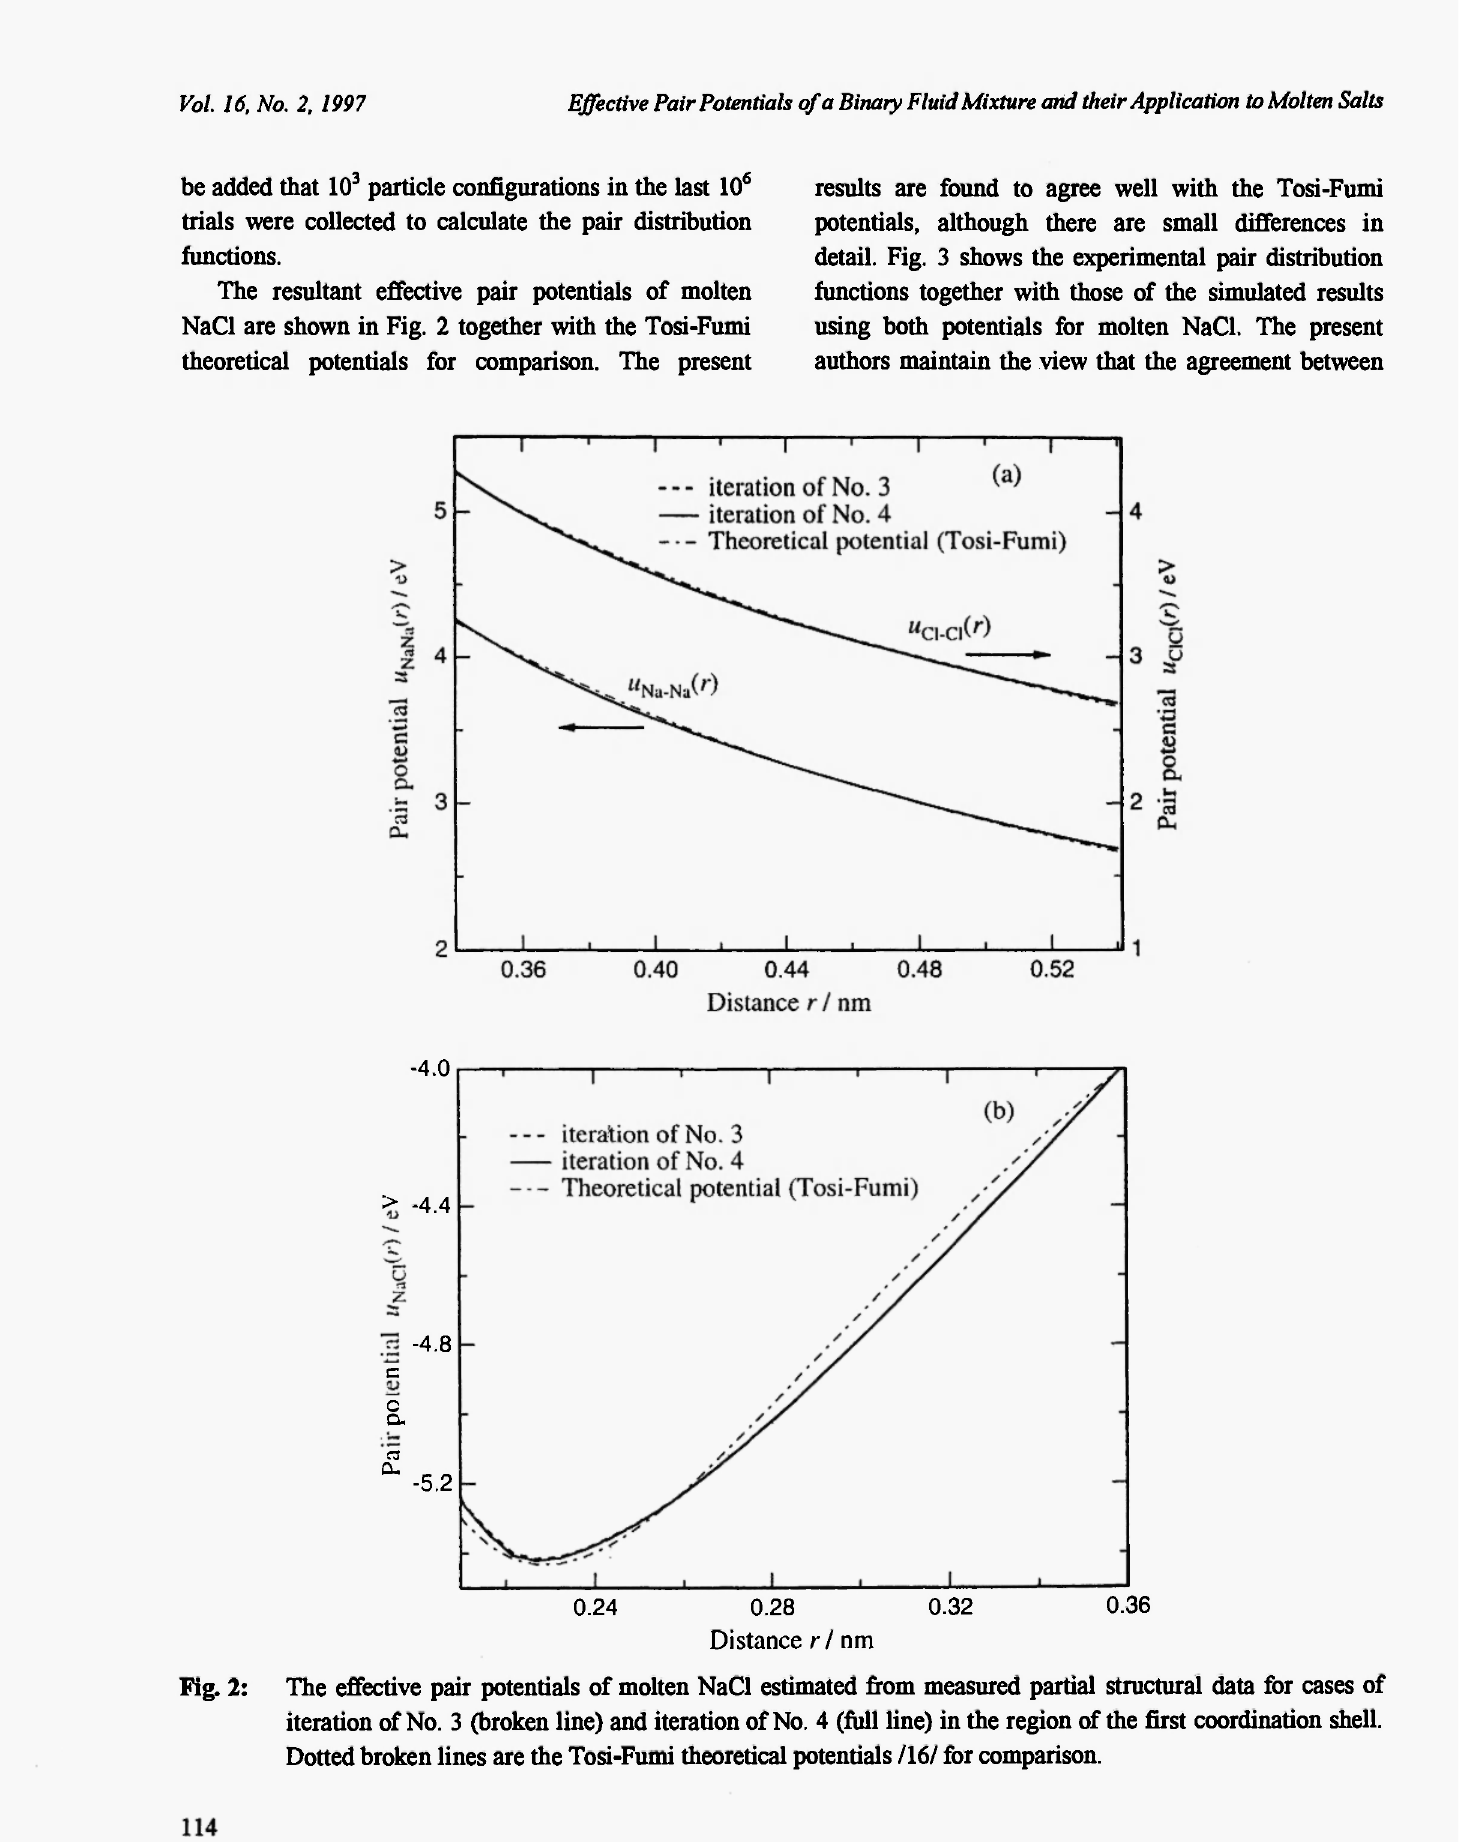
Fig. 2: The effective pair potentials of molten NaCl estimated from measured partial structural data for cases of iteration of No. 3 (broken line) and iteration of No. 4 (full line) in the region of the first coordination shell. Dotted broken lines are the Tosi-Fumi theoretical potentials /16/ for